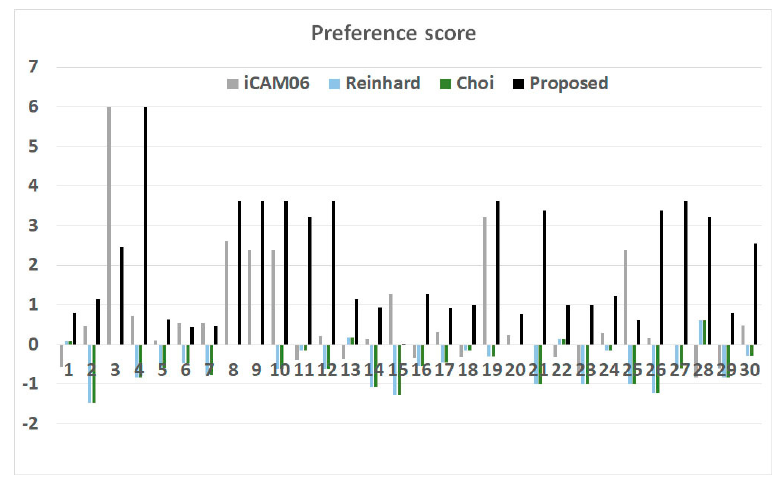
Figure 14. Preference score with 20 different images.